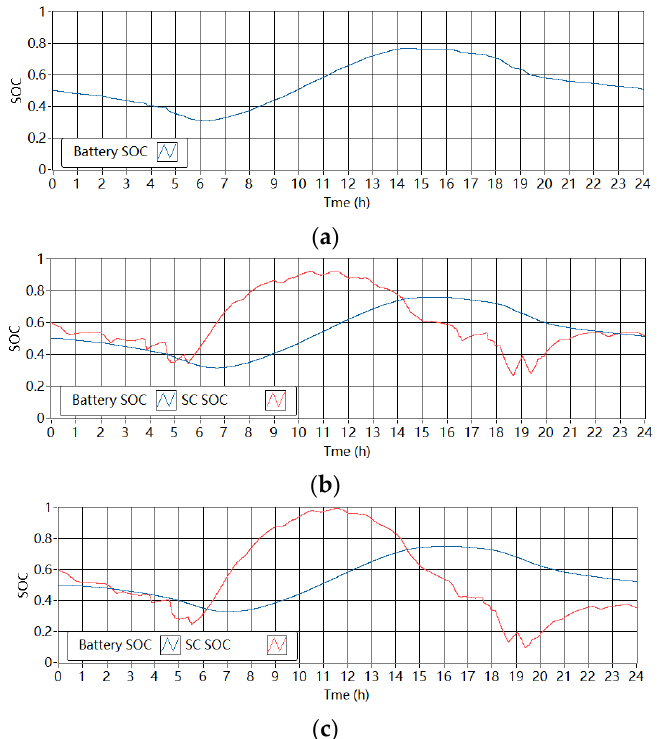
Figure 15. SOC of the ESDs in the experimental setup in the PV-powered system. ( a ) Single-battery ESS. ( b ) Battery-SC HESS when T f is 1800 s. ( c ) Battery-SC HESS when T f is 3600 s.